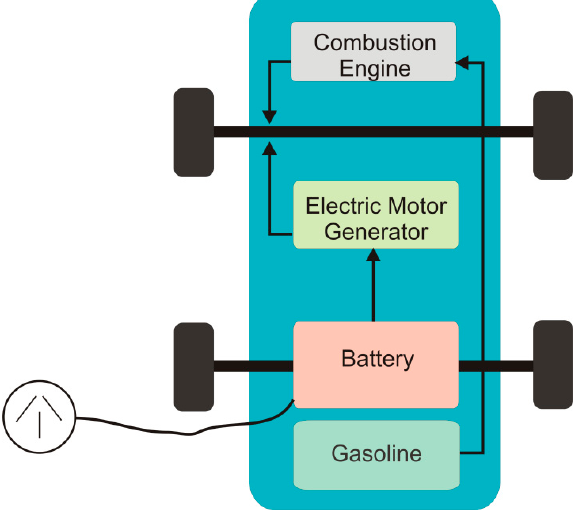
Figure 7. Architectural diagram of range extender hybrid electric vehicles (REHEVs).